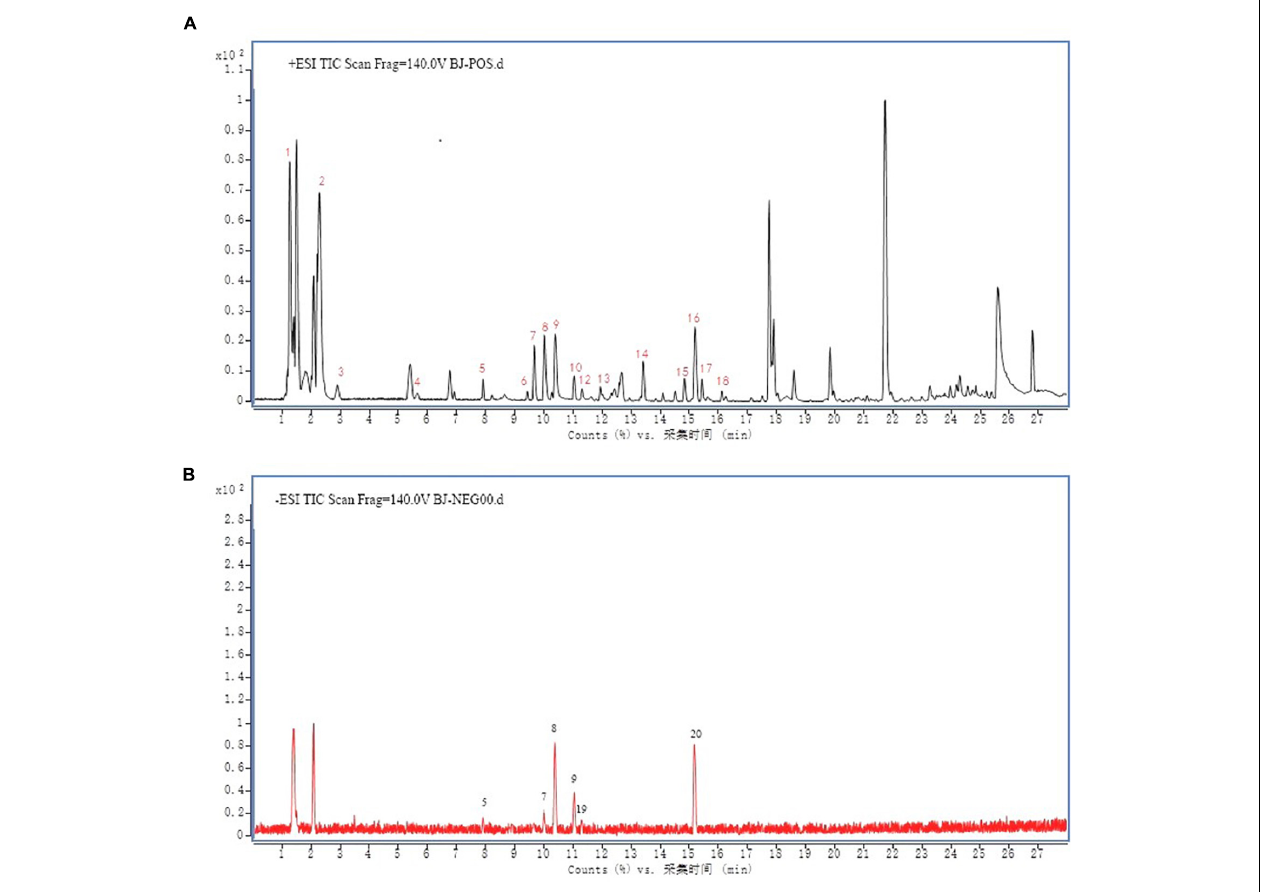
FIGURE 1 | Twenty compounds from BJ were detected by LC-MS/MS analysis in positive and negative ion mode. The chromatographic conditions were as follows: (A) Positive ion mode. (B) Negative ion mode. Agilent 6530 quadrupole-time of flight mass spectrometry (Q-TOF-MS) system, ACQUITY UPLC HSS T3 (2.1 mm × 150 mm, 1.7 µ m) column temperature 60 ◦ C. 1. Luteolin, 2. L-tert-Leucine, 3. Vanillic acid, 4. 5-Hydroxymethylfurfural, 5. Loganic acid, 6. Loganin, 7. Sweroside, 8. Albiflorin, 9. Paeoniflorin, 10. Calycosin 7-O-Glucoside, 11. isoliquiritin apioside, 12. Liquiritigenin, 13. Isorhamnetin, 14. Cynaroside, 15.